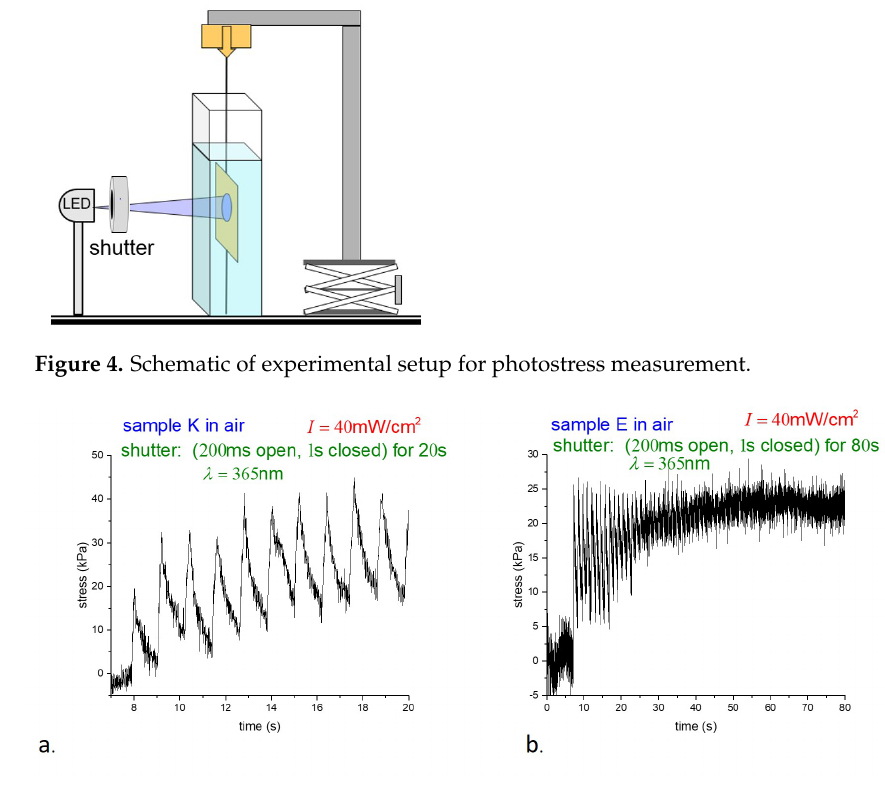
Figure 5. Photostress in air for ( a ) sample K and ( b ) sample E.